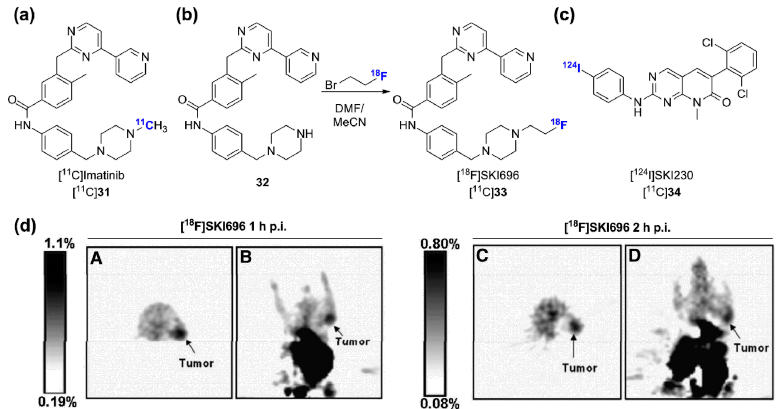
Figure 10. Bcr-Abl targeted radiotracers. ( a ) Chemical structure of [ 11 C]imatinib; ( b ) Radiosynthesis of [ 18 F]SKI696; ( c ) Chemical structure of [ 124 I]SKI230; ( d ) Transverse and coronal [ 18 F]SKI696 PET images of K562 tumor bearing mice at 1 h p.i. ( A , B ) and 2 h p.i. ( C , D ) (this research was originally published in [127] © the Society of Nuclear Medicine and Molecular Imaging, Inc.).